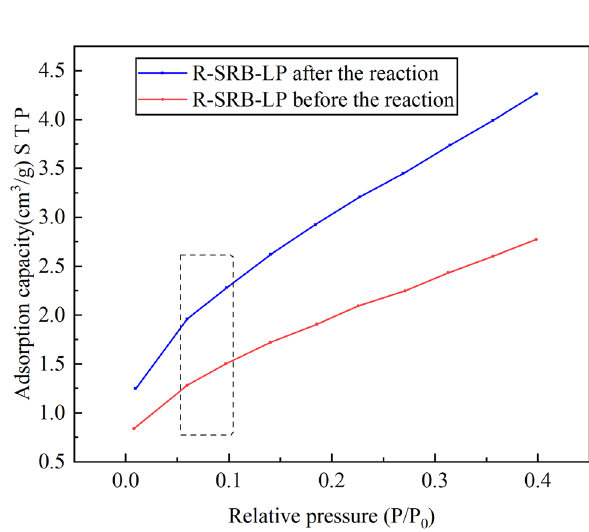
Table 2. Specific surface area analysis.